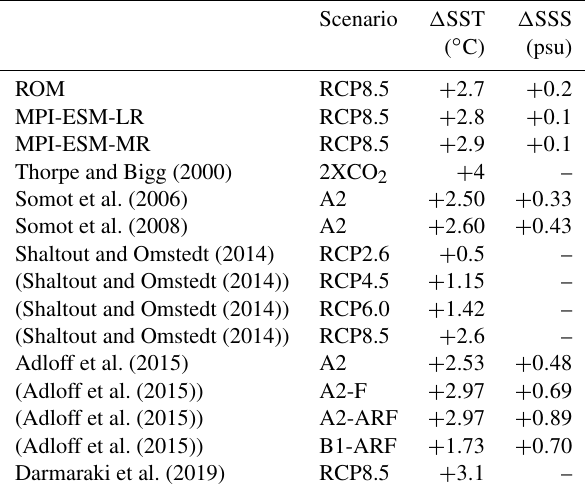
Table 6. Mediterranean Sea average spatial changes in SST and SSS by the end of the 21st century as compared with the present climate.